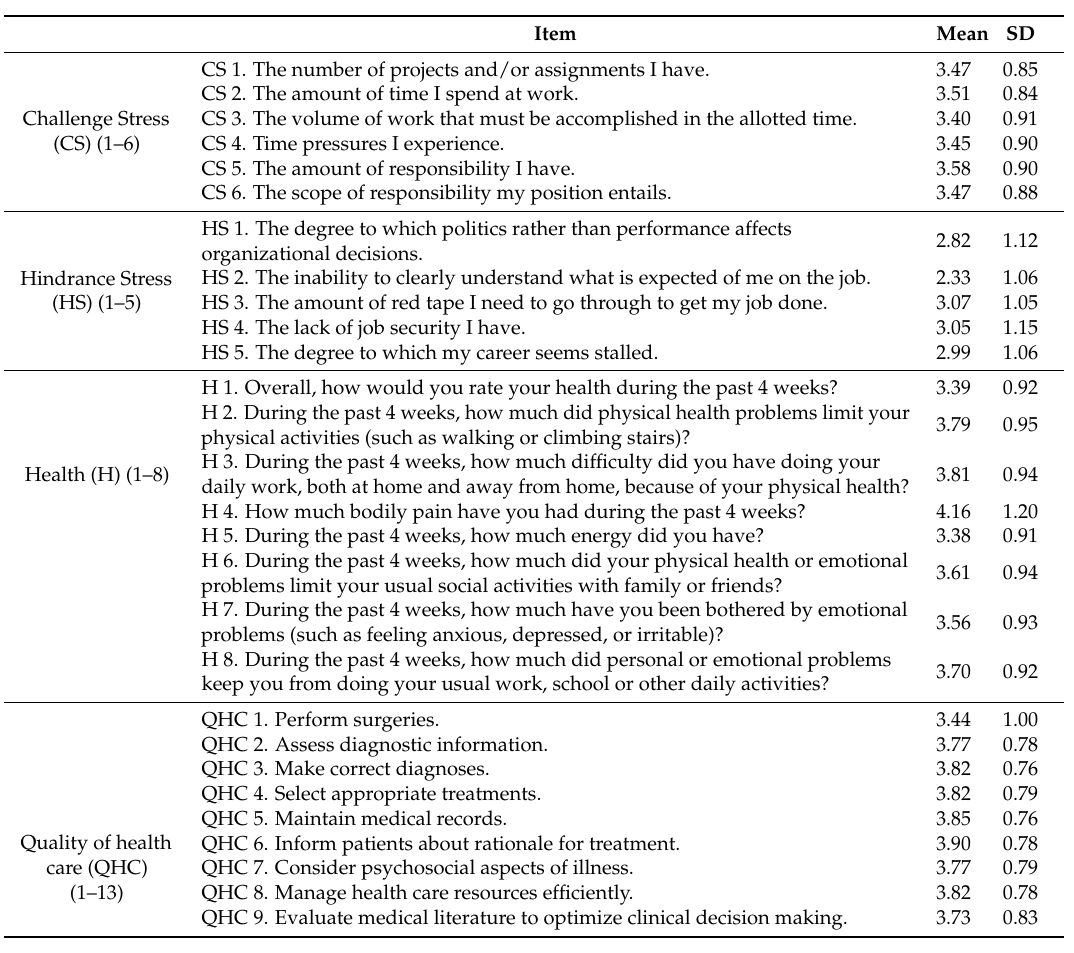
Table 1. Mean and standard deviation (SD) of the items of challenge stress, hindrance stress, health, and the quality of health care. Item Mean